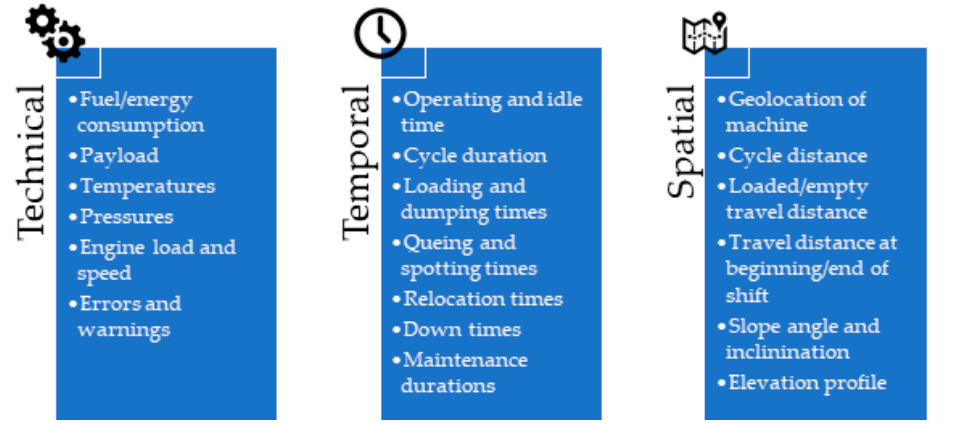
Figure 4. Mining KPIs from technical, temporal, and spatial dimensions.